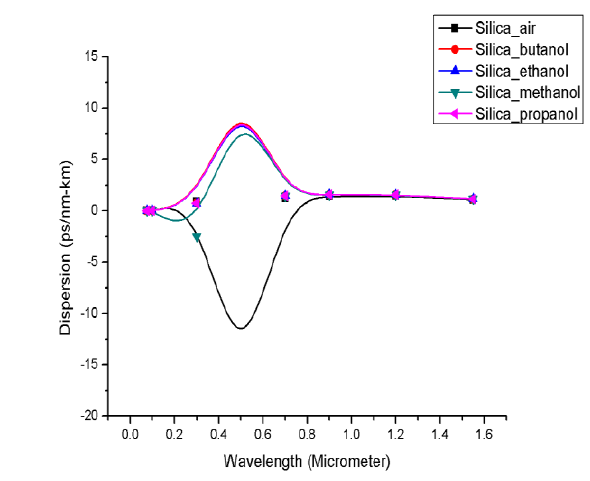
Figure 2: Dispersion behavior at different wavelengths Air diameter of the inner most ring of PCF strongly determines its dispersion properties. Slope of waveguide dispersion compensate the slope of material dispersion in single mode PCF with smaller air hole diameter in the inner most ring [38-39]. Fig. 2 shows the dispersion behavior of all the five PCF structures simulated in this paper. Ultra flattened zero dispersion over visible range to far infrared region is obtained. Flattened zero dispersion over such a wide band of wavelength, is capable enough to make the nonlinear effects preponderant in these bands. Diameter or dimension of holes in the cladding region, center to center spacing in between holes and number of air holes in the ring strongly affect confinement loss. Confinement loss increases with increase in wavelength.